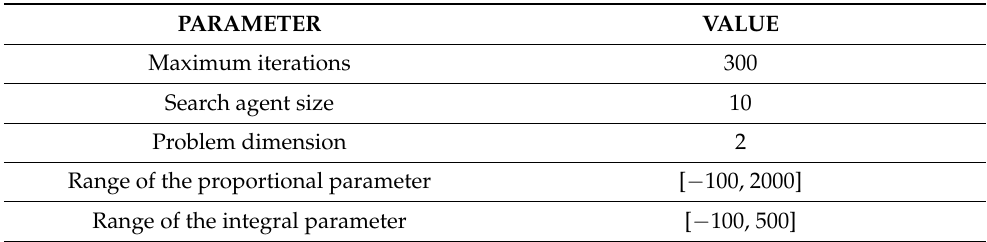
Table 2. Initial parameters for WOA.